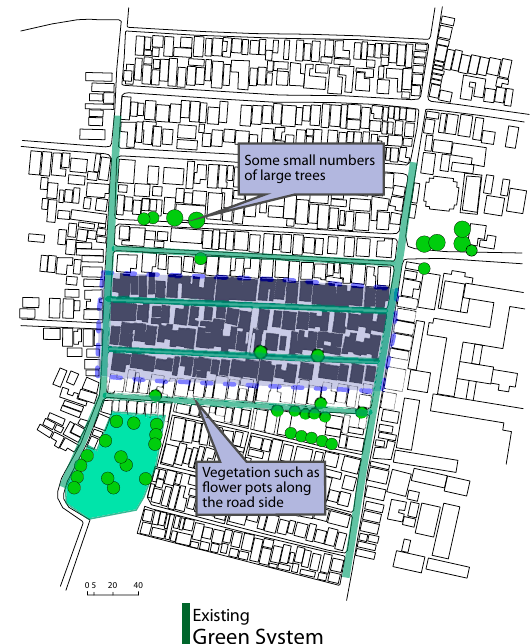
fig. 6. Distribution of existing vegetation and open space in Kampung Karangrejo Sawah (created by the author)